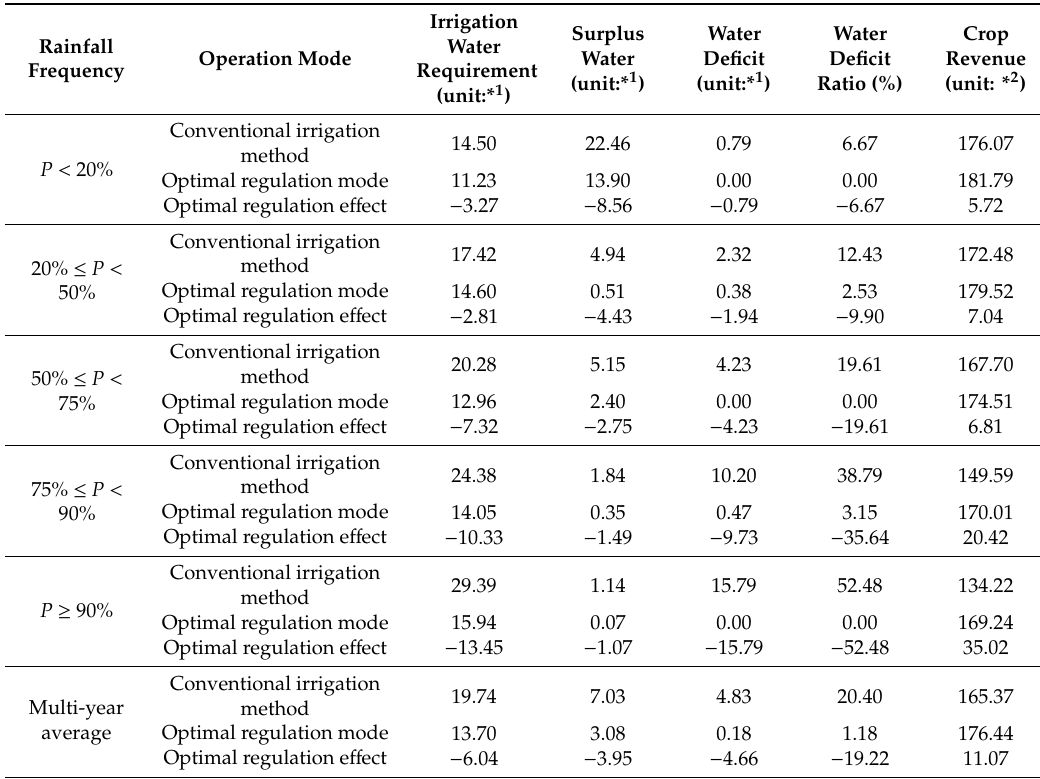
Table 3. Comparison of average crop revenues between the conventional method and optimal regulation mode under di ff erent rainfall frequencies in the pond irrigation district of Yangdian